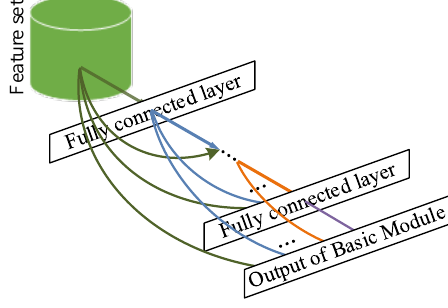
Figure 6. The architecture of the basic module in the two-stream deep feature fusion